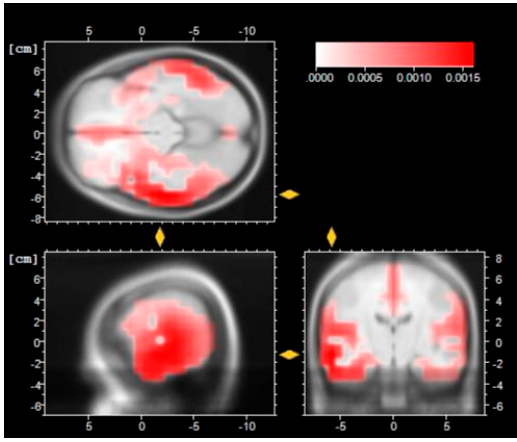
Figure 11. LORETA reconstruction of N1 after the haptic manipulation session.